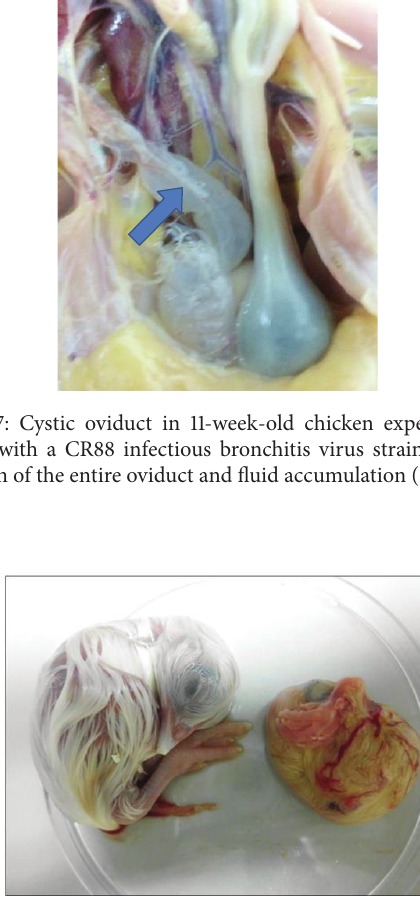
Figure8:Embryodevelopmentat17daysoldfollowinginoculations with IBV-CR88 strain. Note evidence of dwarfism and curling of the toes in IBV infected embryo (right) compared to a noninfected control embryo